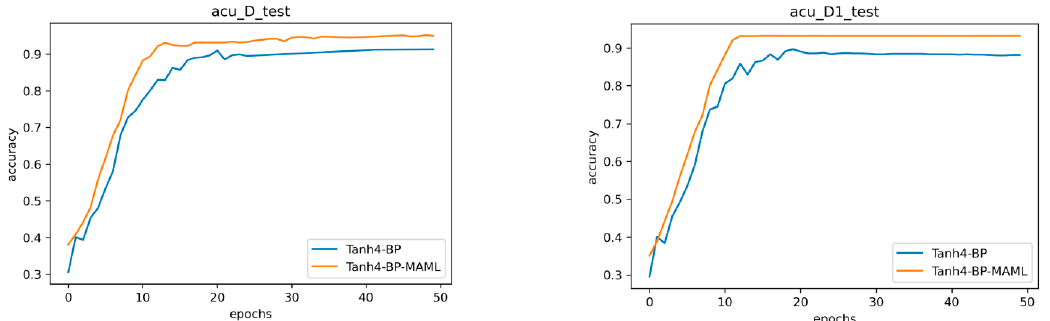
Figure 12. Comparison of accuracy of different models with different datasets. Table 5. Comparison of training time of different models with different